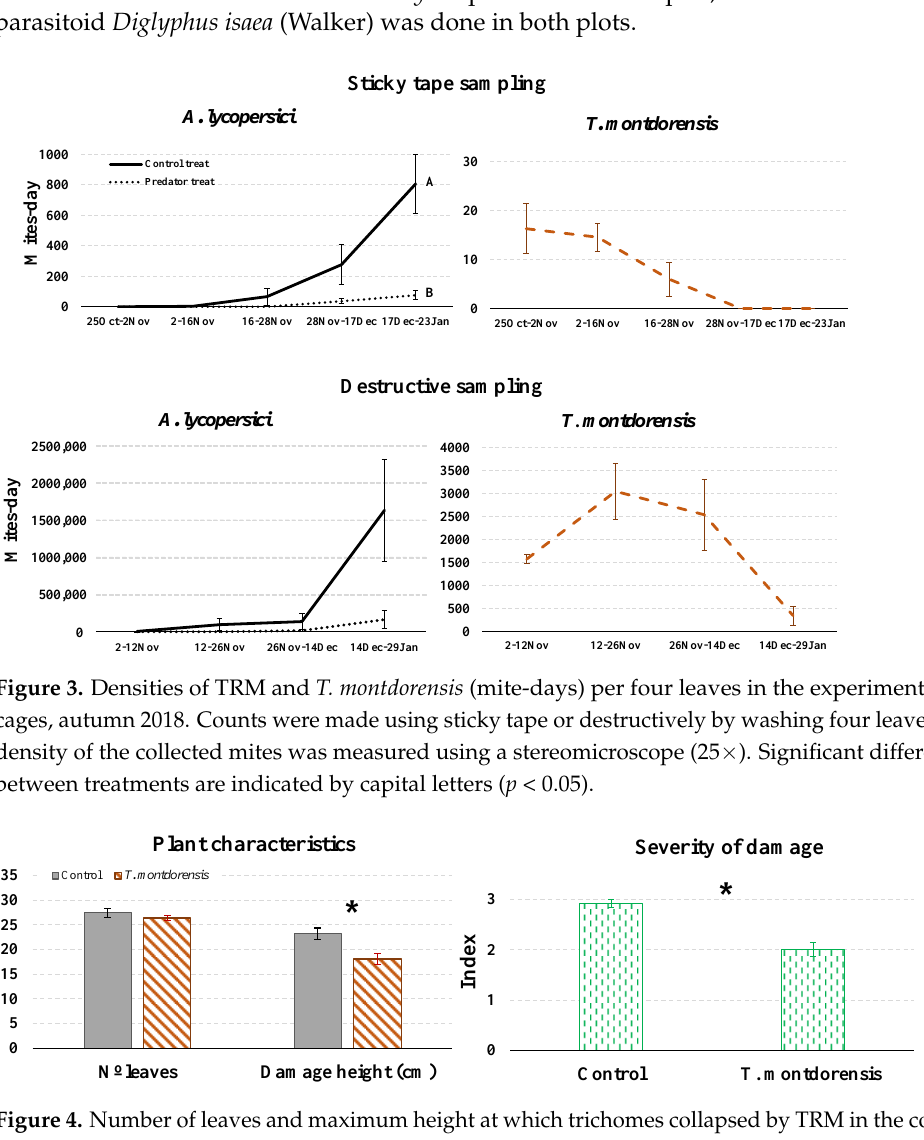
Figure 4. Number of leaves and maximum height at which trichomes collapsed by TRM in the control and predator treatments on the last sampling date. The figure also shows the severity of the damage in the upper part of the stem: (0) no damage, (1) very small spots or trails of collapsed trichomes, (2) large patches of collapsed trichomes, and (3) collapsed trichomes around the entire perimeter of the stem. Black asterisks indicate significant differences between treatments ( p < 0.05).